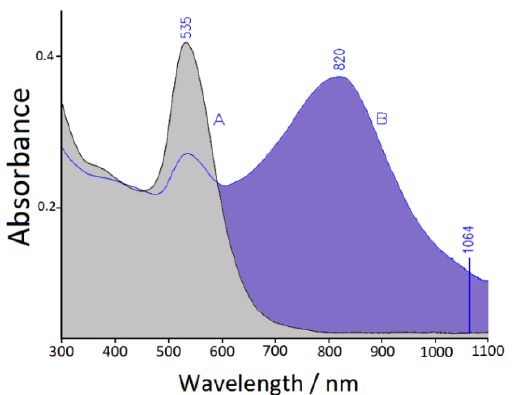
Figure 3. UV-vis-near infrared (NIR) extinction spectrum of Au colloids with 10 ‒ 6 M xanthine, before (A) and after (B) the addition of 10 ‒ 3 M NaCl. The 1064 nm excitation laser line is indicated.